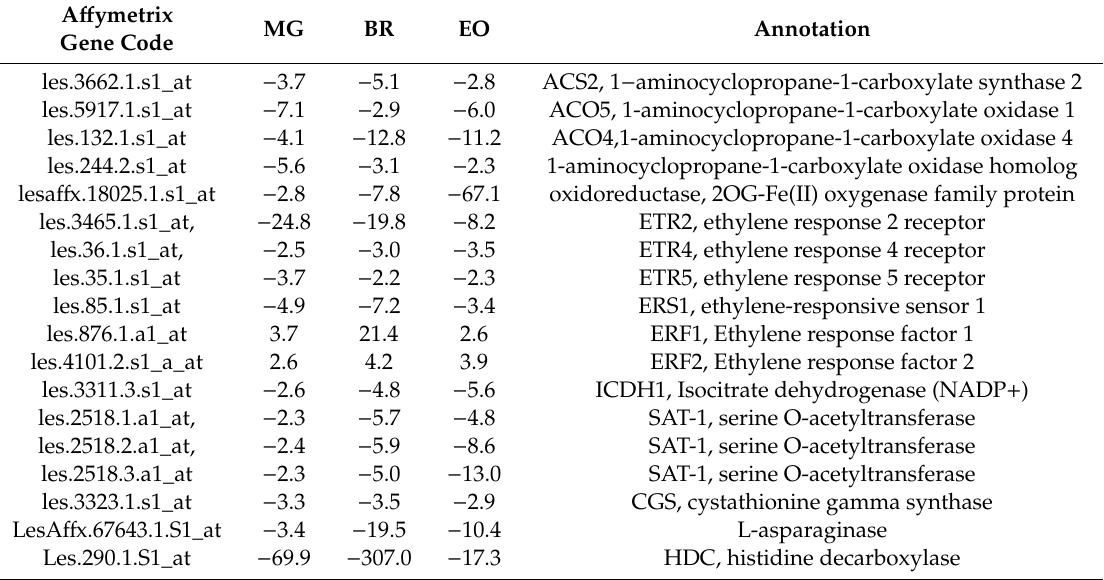
Table 2. The average fold change of genes related to ethylene biosynthesis and signal transduction, respiration, and amino acid metabolism that were a ff ected by 1-MCP treatment at di ff erent ripening stages (for control samples n = 3, for 1-MCP samples n =